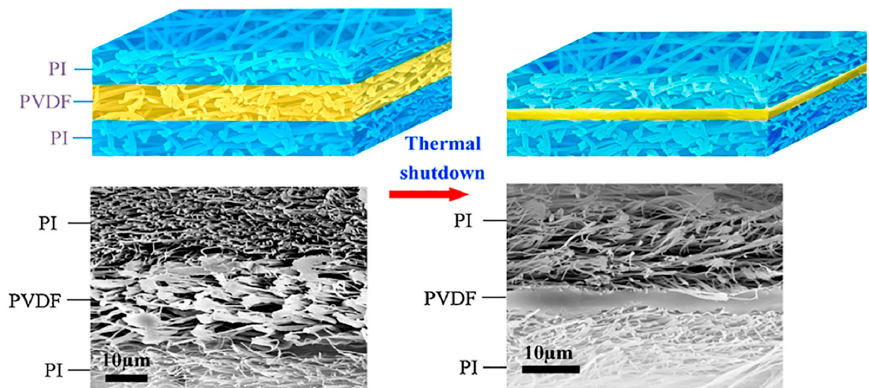
Figure 8. Figure and cross-sectional SEM images of the PI / PVDF / PI membrane before and after the hot melting and shutdown behavior of the PVDF nanofibers layer. Reprinted with permission from [115]. Copyright (2015) Elsevier Ltd.